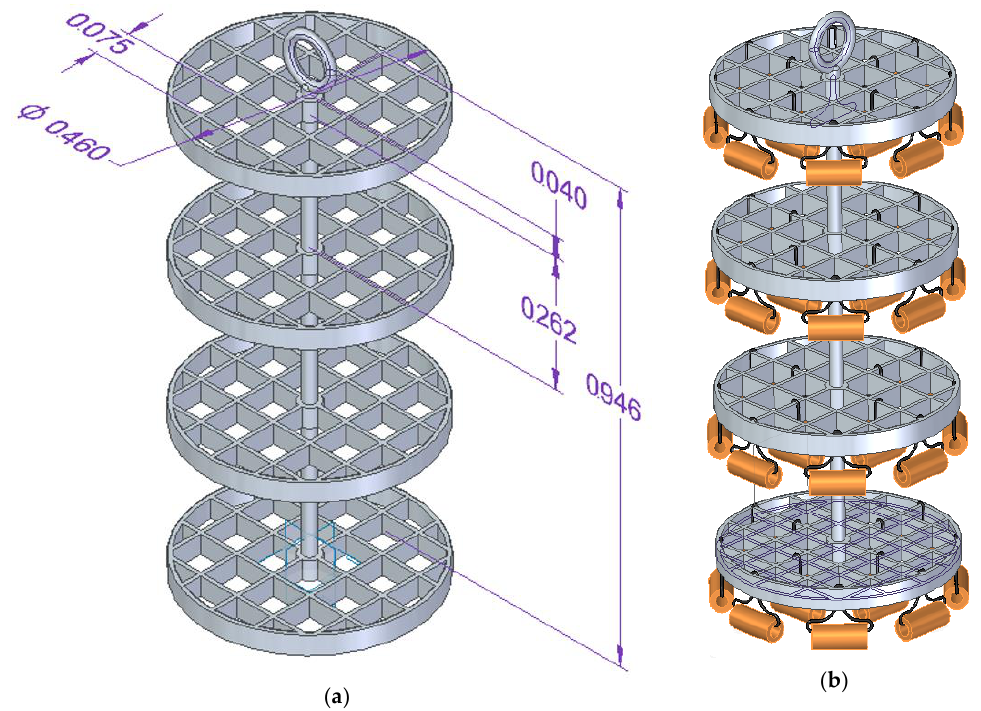
Figure 7. Stainless steel charging basket. ( a ) Empty basket; ( b ) loaded with parts to be tempered.